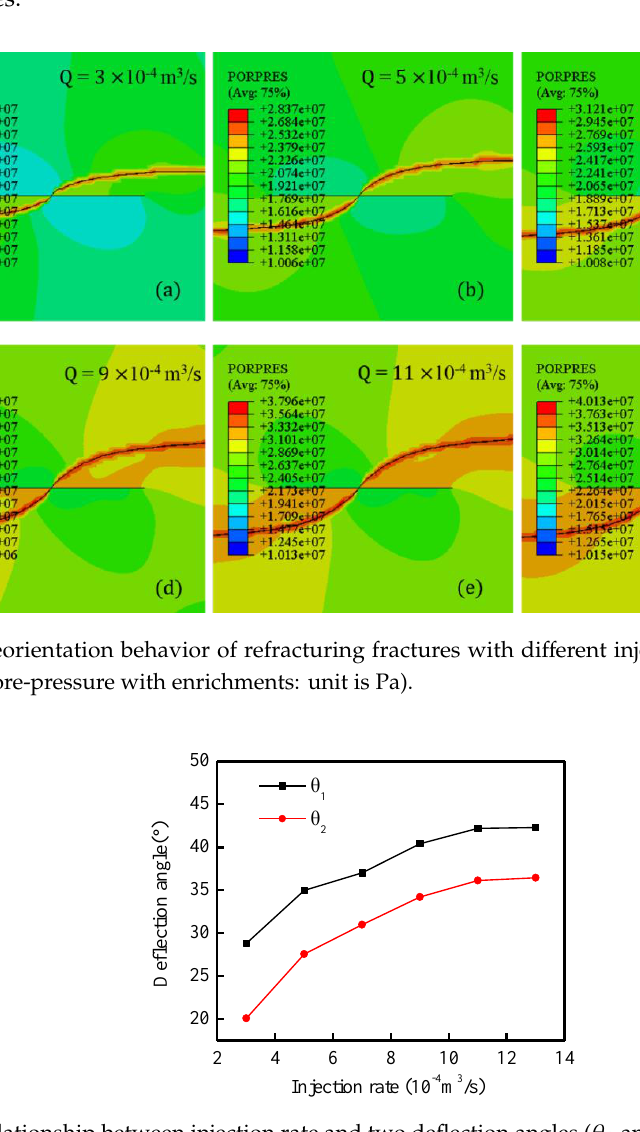
Figure 12. Relationship between injection rate and two deflection angles ( θ 1 and θ 2 corresponding to quarter-length (10 m) and the half-length (20 m) deflection angle, respectively).